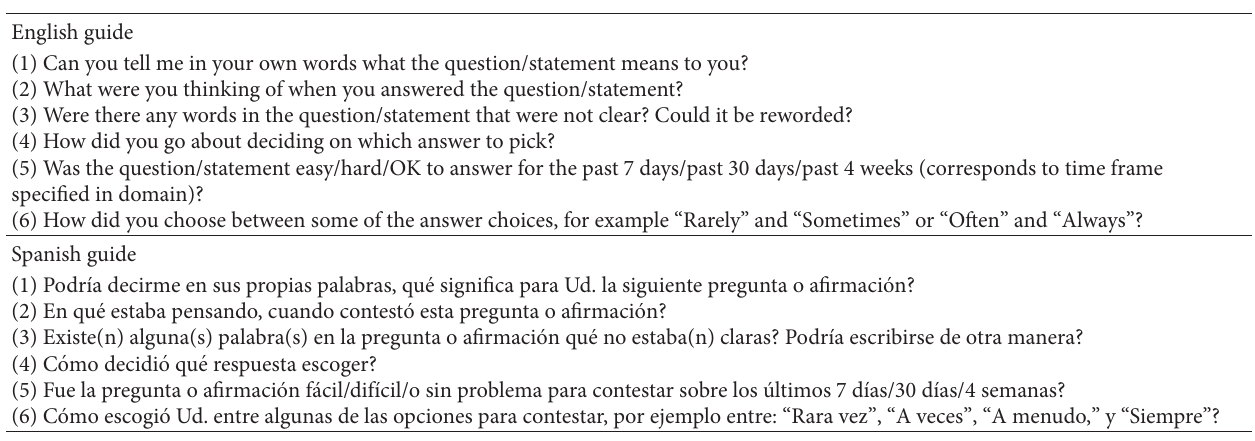
Table 3: The cognitive interview guide for